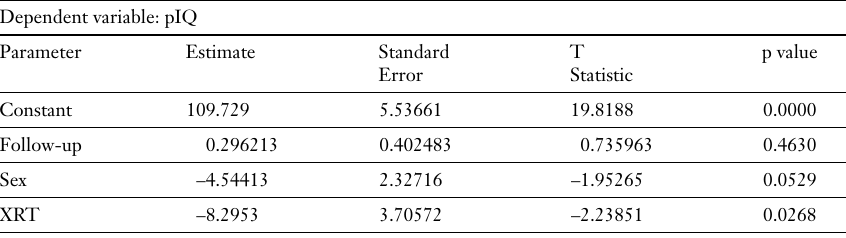
Multiple regression analysis